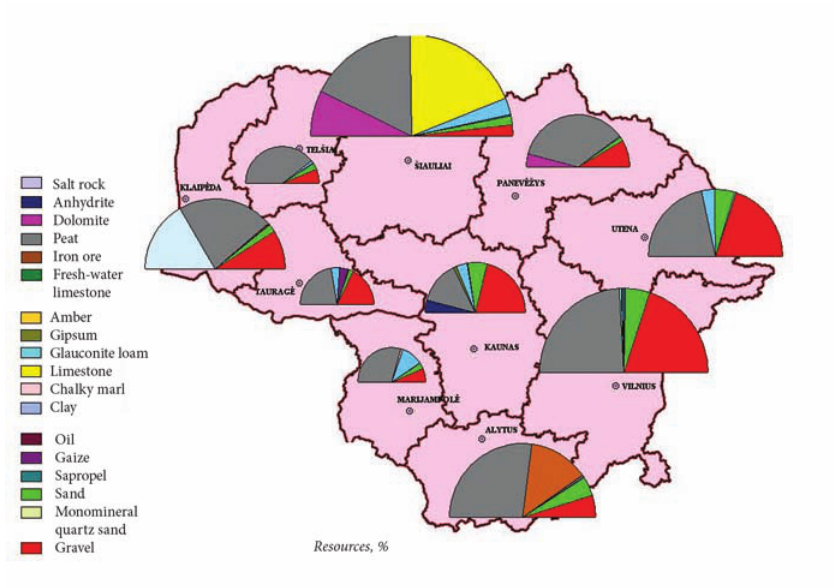
Fig. 1. Mineral resources explored in detail and in general in the counties of the Republic of Lithuania according Lithuanian Geological Survey in